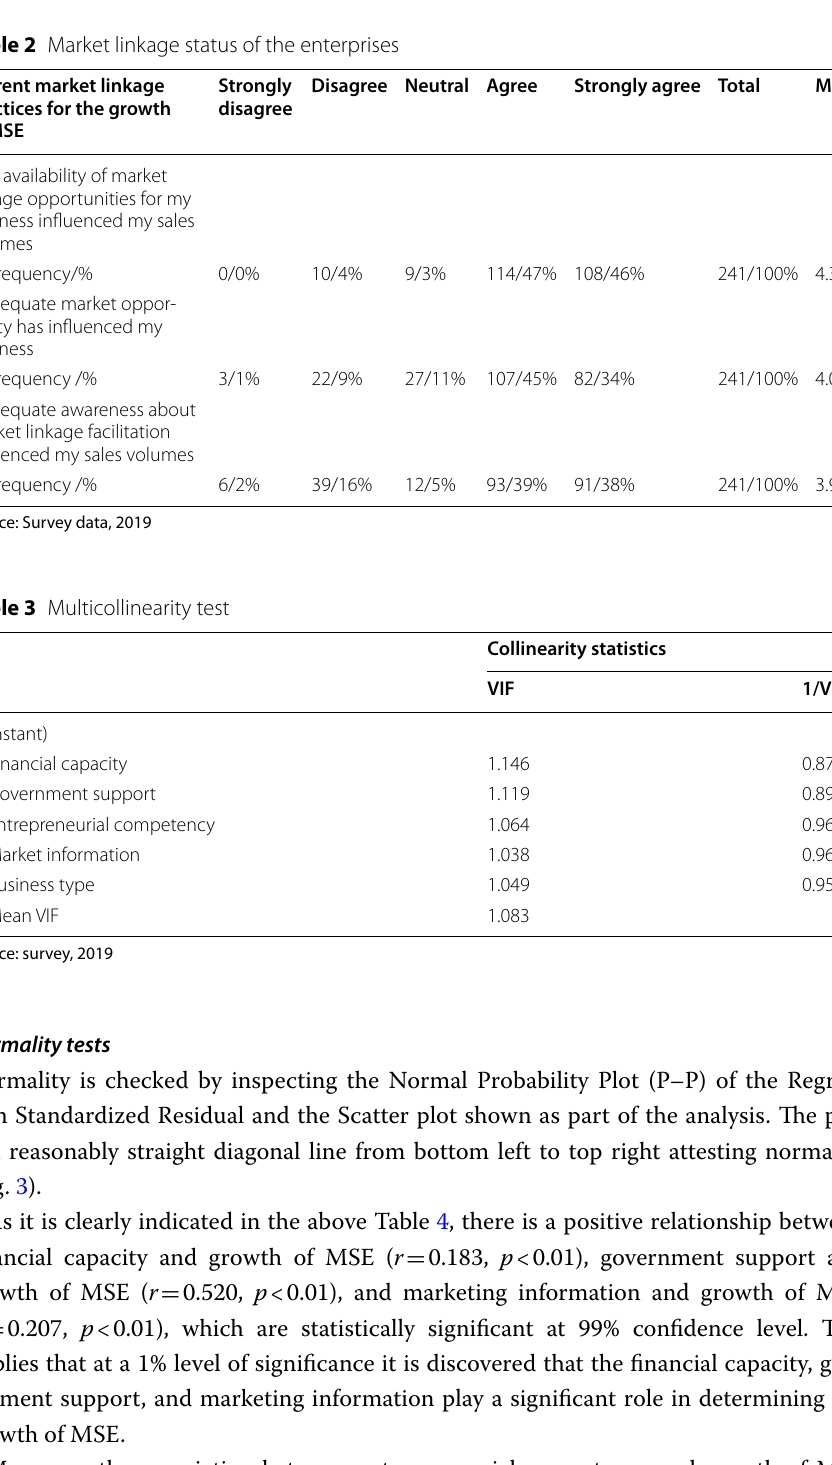
Table 2 Market linkage status of the enterprises